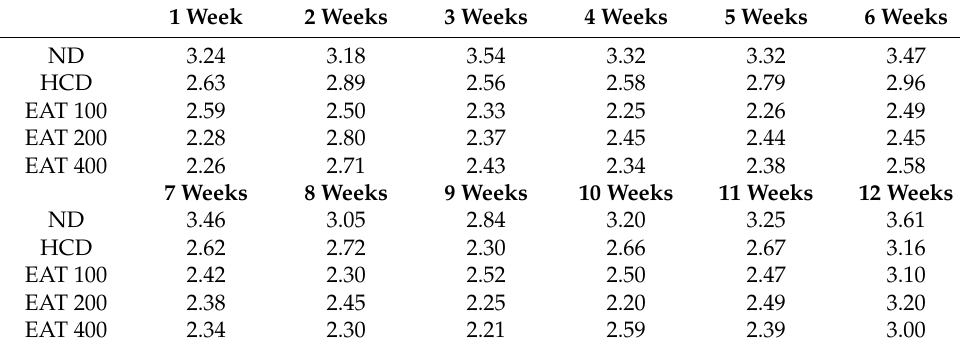
Table 3. Food intake of normal diet (ND) and HCD groups in an HCD-induced C57BL/6 mouse model.